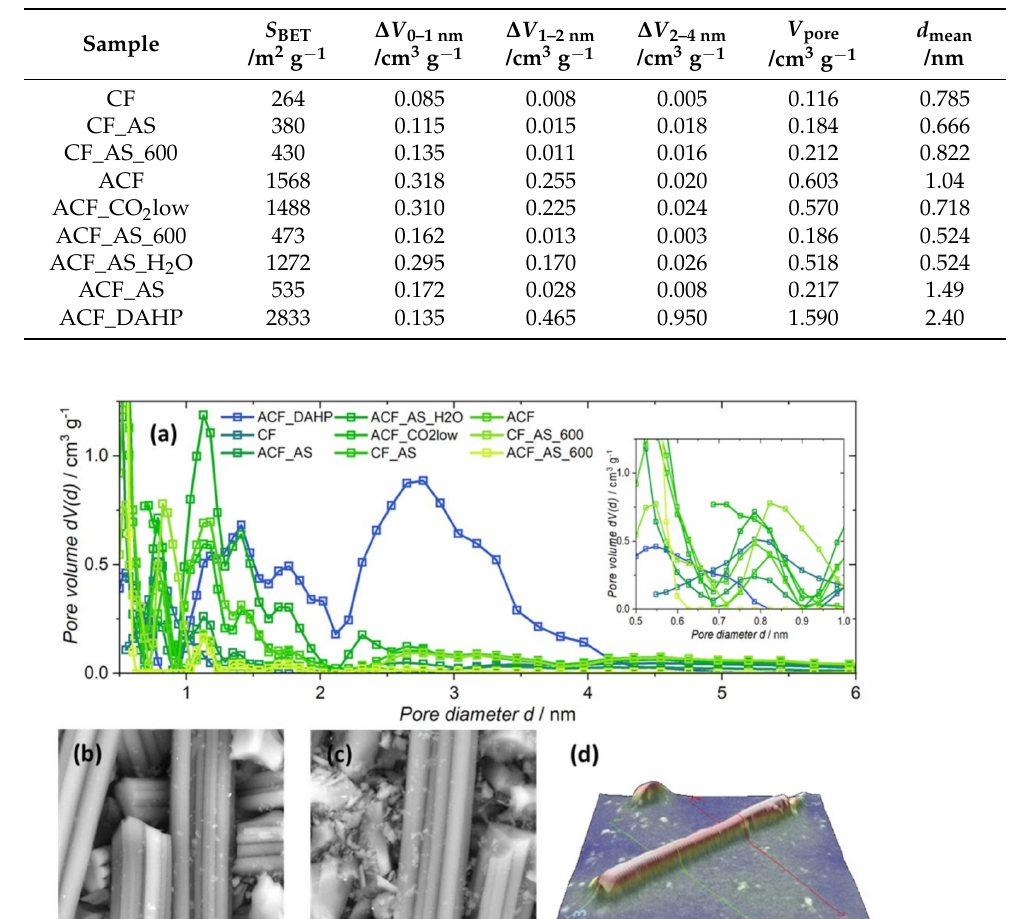
Table 2. Textural properties of studied carbon materials ( S BET —specific surface area, ∆ V —pore